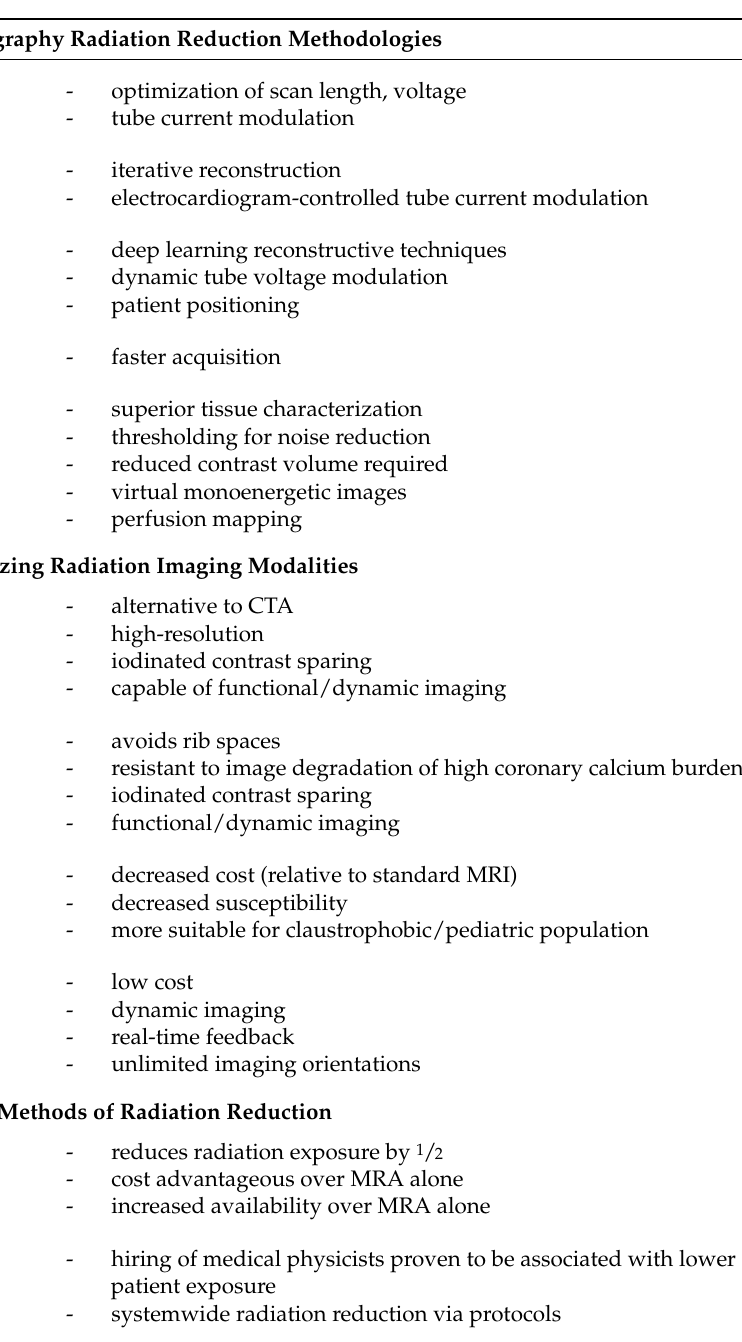
Table 1. Radiation Dose Reduction